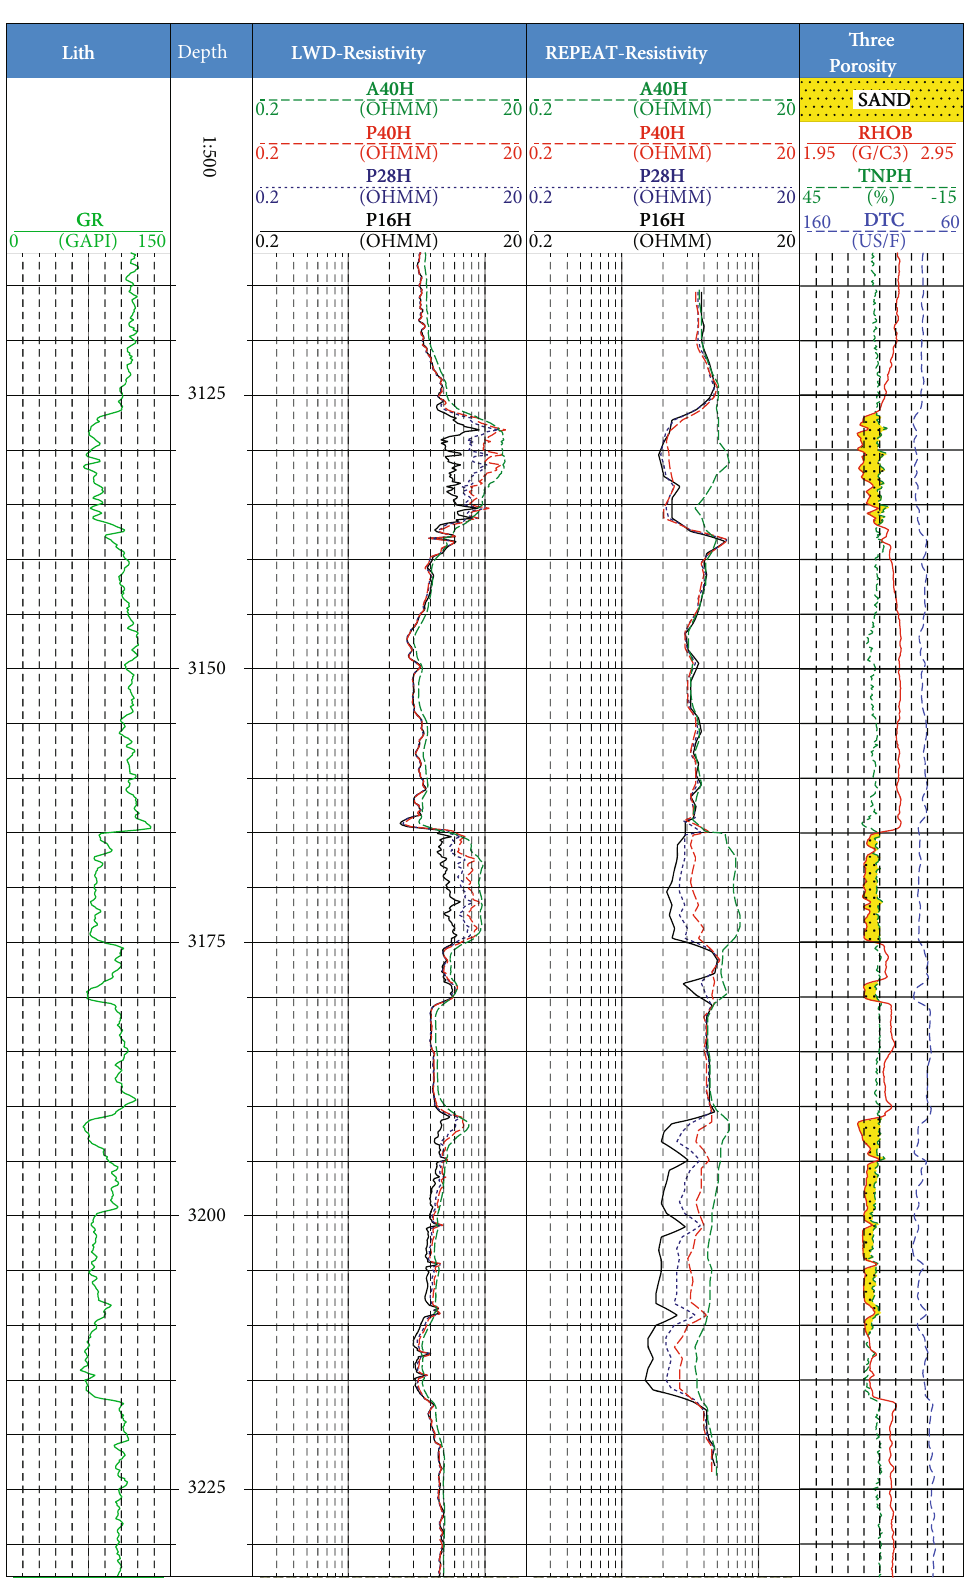
Figure 8: Electromagnetic wave resistivity measurement curve of well xx during the drilling and